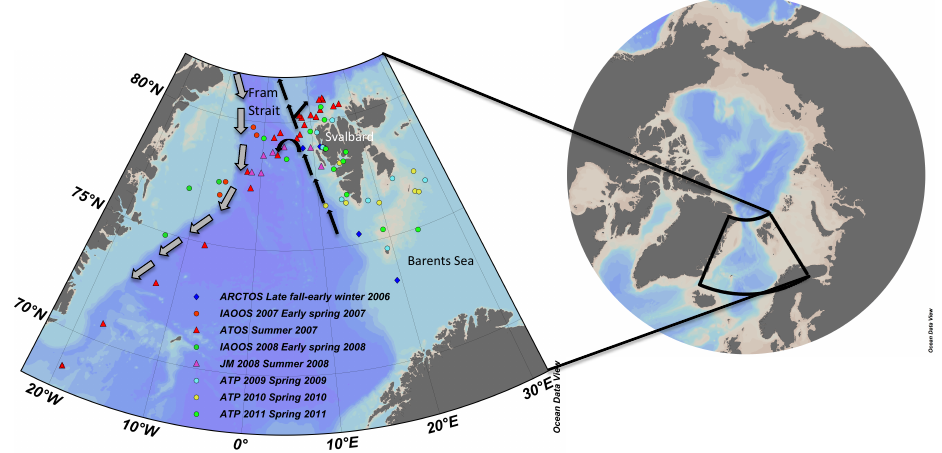
Fig. 1. Map showing the location of the stations sampled along the 8 cruises covering the northern Fram Strait, Spitsbergen waters and the western Barents Sea. Arrows indicate the direction of the main currents present in the area, the West Spitsbergen Current (WSC, thin black arrows) and the East Greenland Current (EGC, thick grey